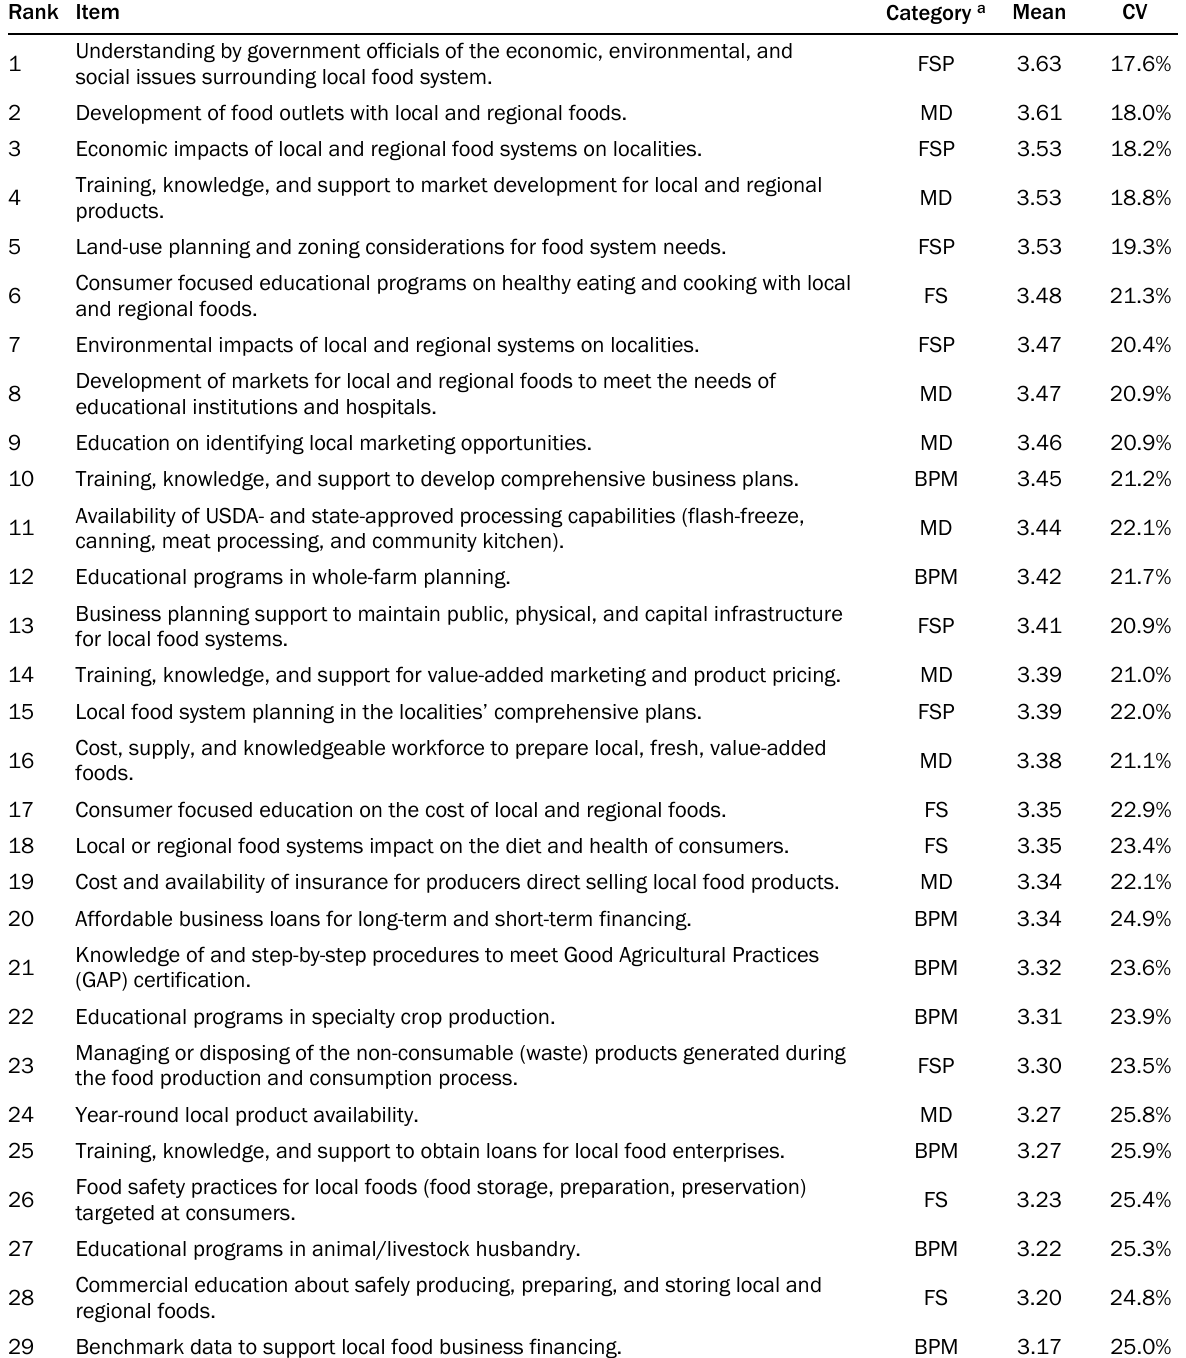
Table 7. Priority Ranking of Survey Items by Mean Score (Most important to less